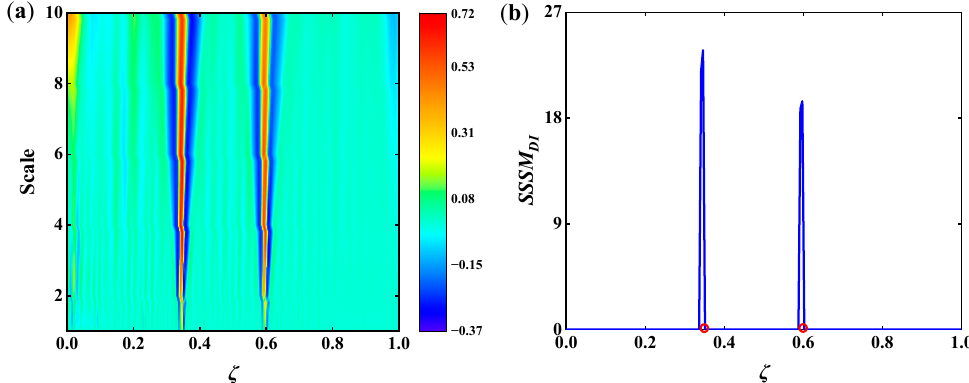
Figure 17. Identification results of cracked cantilever beam under scenario I when γ = 5%: ( a )